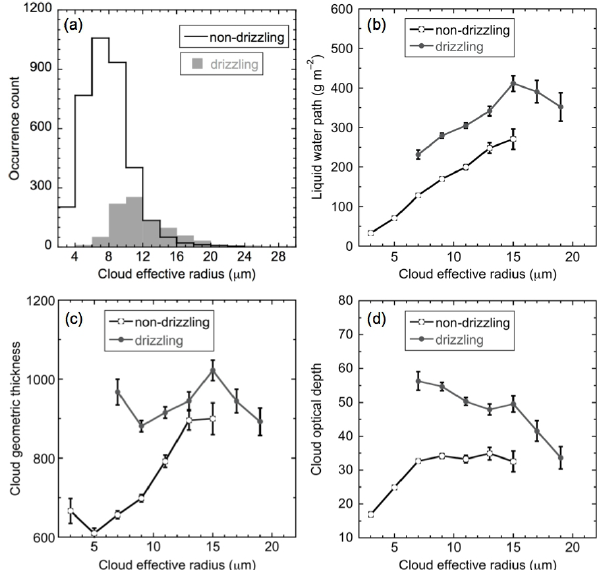
Figure 10. Same as Fig. 8 but using cloud optical depths from the ARM Archive Min product. Note that the power-law relationships between cloud geometric thickness and optical depth by dashed and dotted lines in (c) are derived from data in Fig. 8 for visual compar-